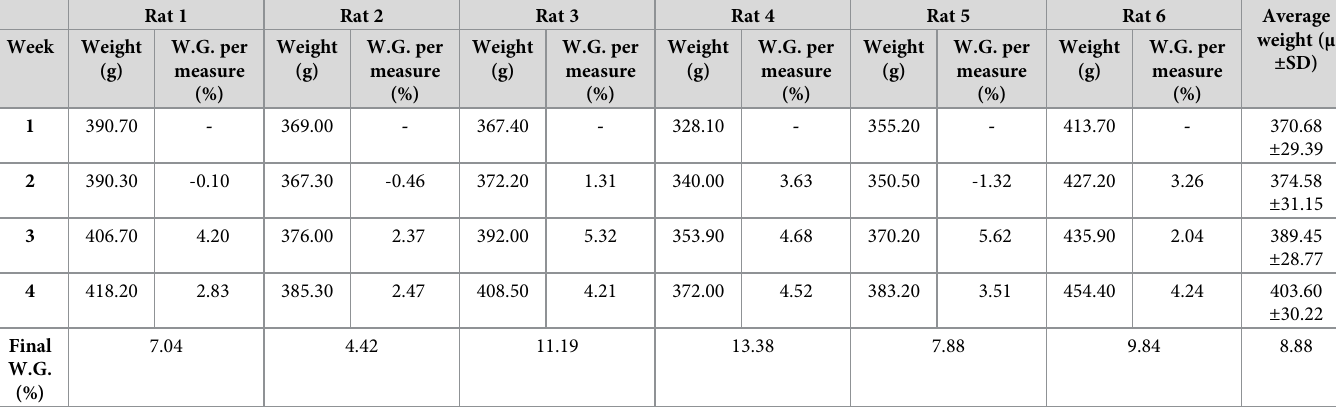
Table 1. Rats weight evolution during the study (from 12 to 16 weeks of age). Each animal was weighed 4 times during the study.